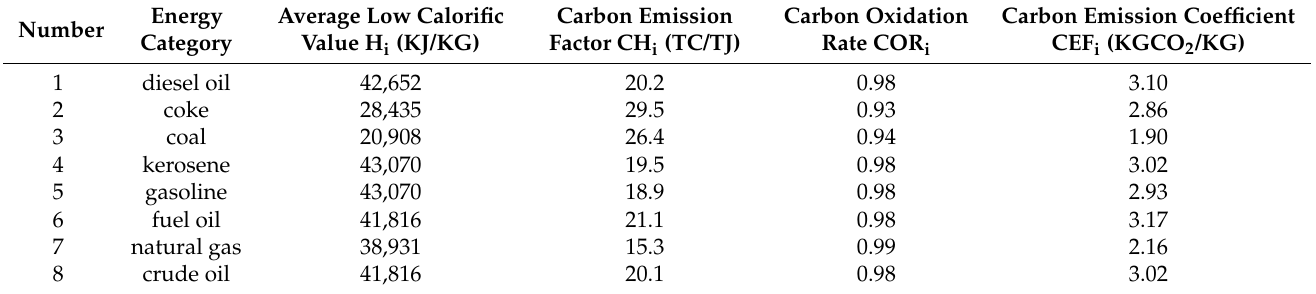
Table 1. Conversion table of the carbon emission coefficient of the major energy